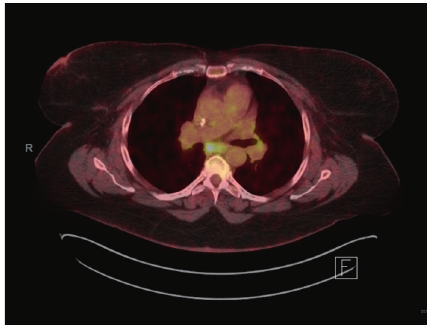
Figure 1: 2/2017 hypermetabolic activity within the subcarinal lymph nodes.